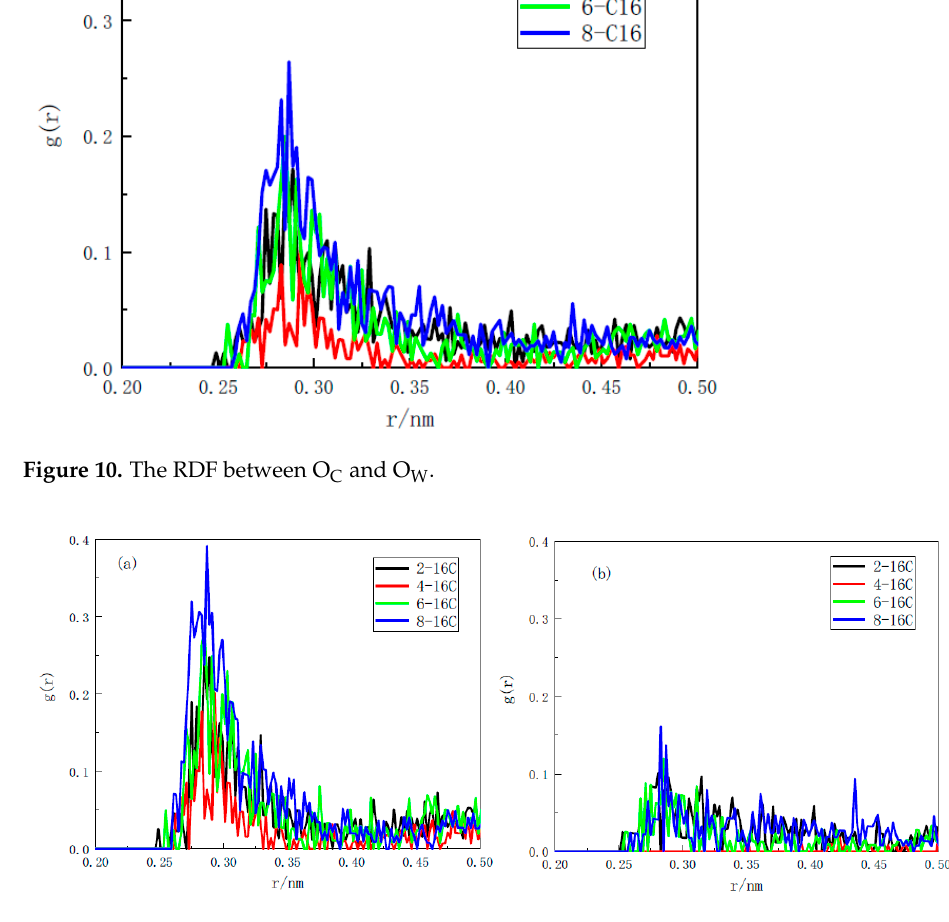
Figure 11. The RDF of ( a ) O H and O w ; ( b ) O K and O w .